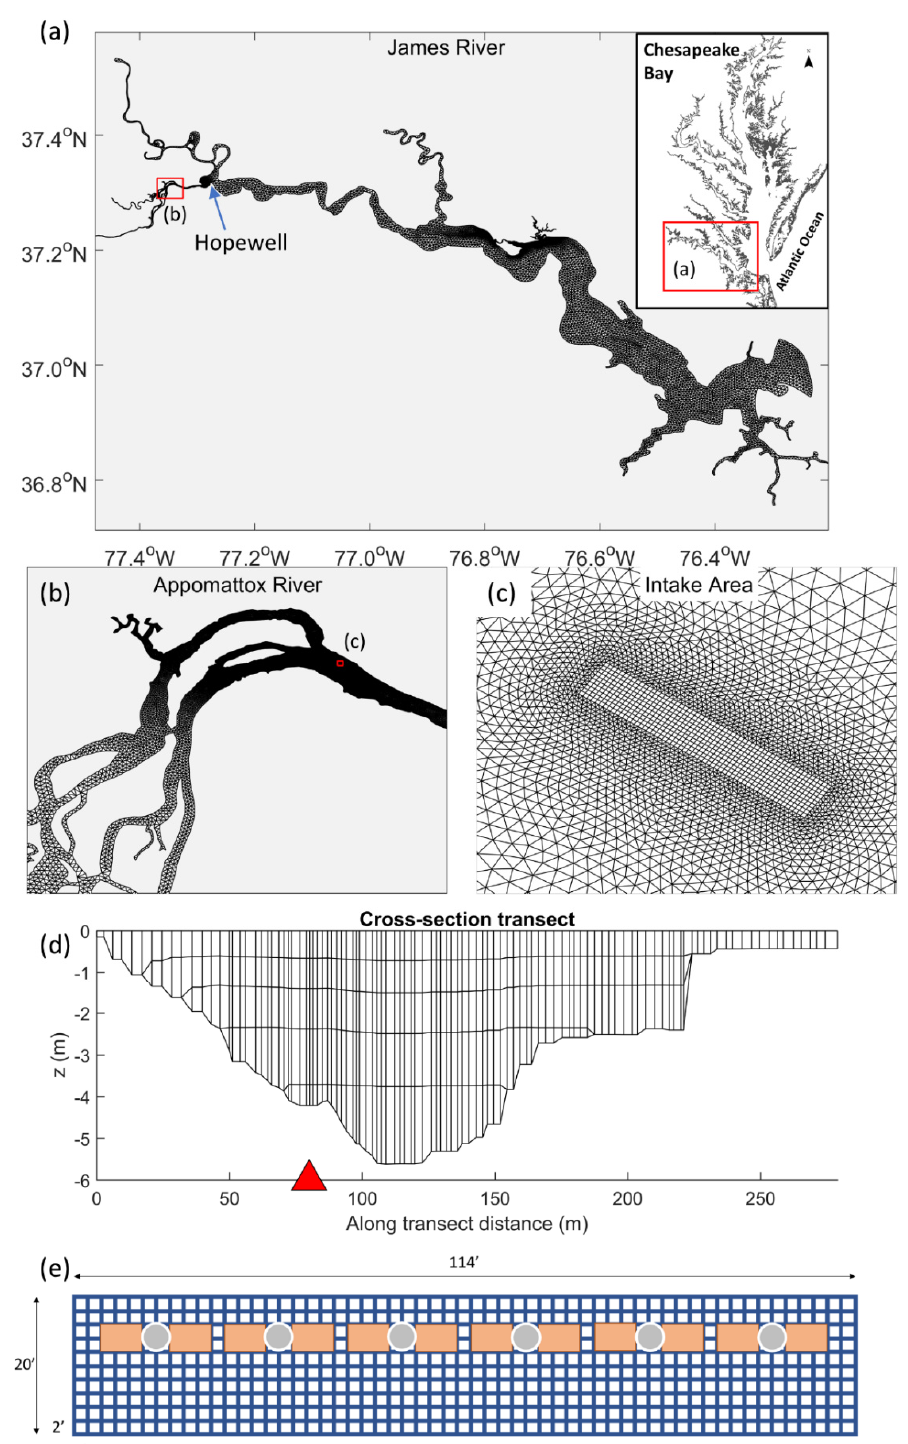
Figure 1. The extended James River model grid with high resolution near the vicinity of the intake. ( a ) The horizontal grid for the James River. ( b ) The refined horizontal grid for the Appomattox River. ( c ) The grid of high resolution for the intake area. ( d ) A cross-sectional transect showing the vertical layers (not the vertical grid) at the intake area (looking downstream). The red triangle marks the location of the intake. ( e ) The horizontal grid designed for the intake area. The length is 34.7 m (114 feet), and the width is 6.1 m (20 feet). Each of the six functional intake screens is represented by 16 grid elements, and the size of each element is 0.61 m × 0.61 m.